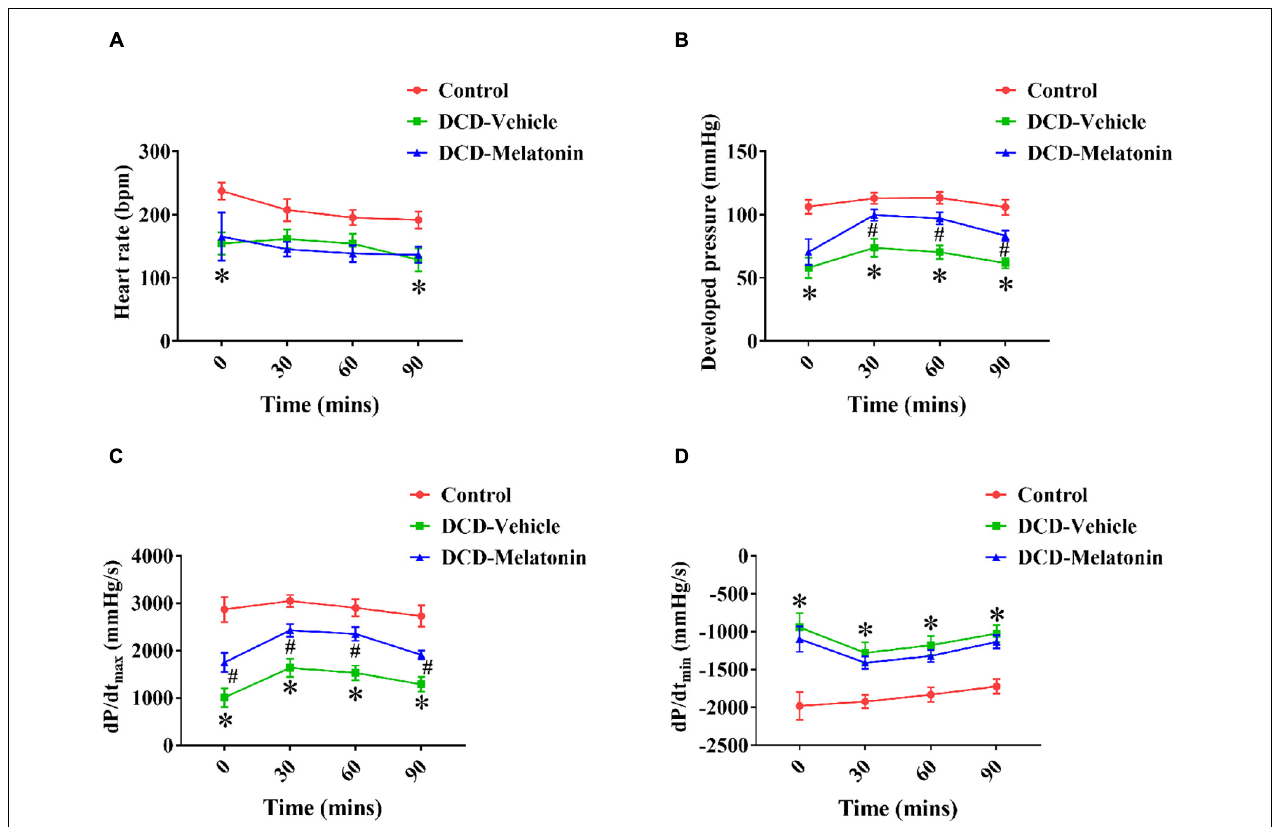
FIGURE 3 | Cardiac functional assessment of the DCD heart during EVHP. (A) Heart rate; (B) developed pressure; (C) d P /d t max ; and (D) d P /d t min . Data represent mean ± standard error of the mean. n = 8 for each group. DCD, donation after circulatory death; EVHP, ex vivo heart perfusion; d P /d t max , maximum rate of rise of left ventricular pressure; d P /d t min , maximum rate of pressure decline. ∗ p < 0.05 vs. control; # p < 0.05 vs. DCD-vehicle.